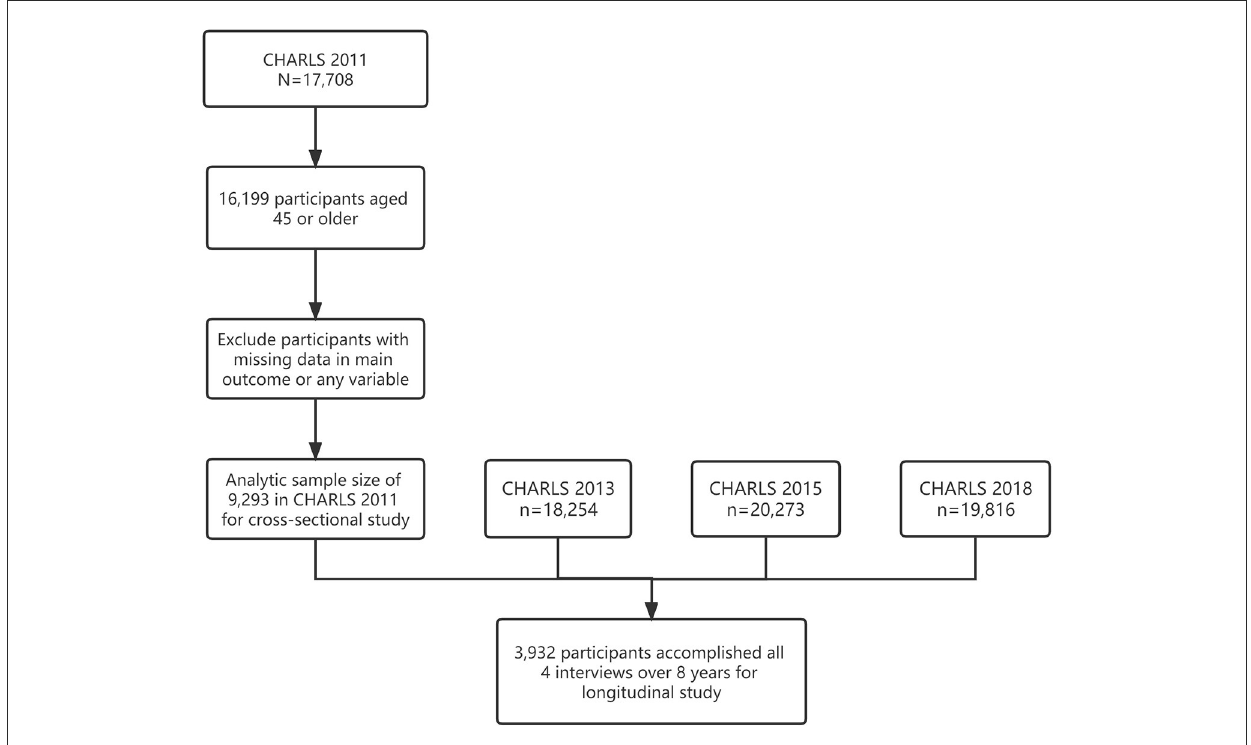
FIGURE1 Graphic abstract of sample screening of the present